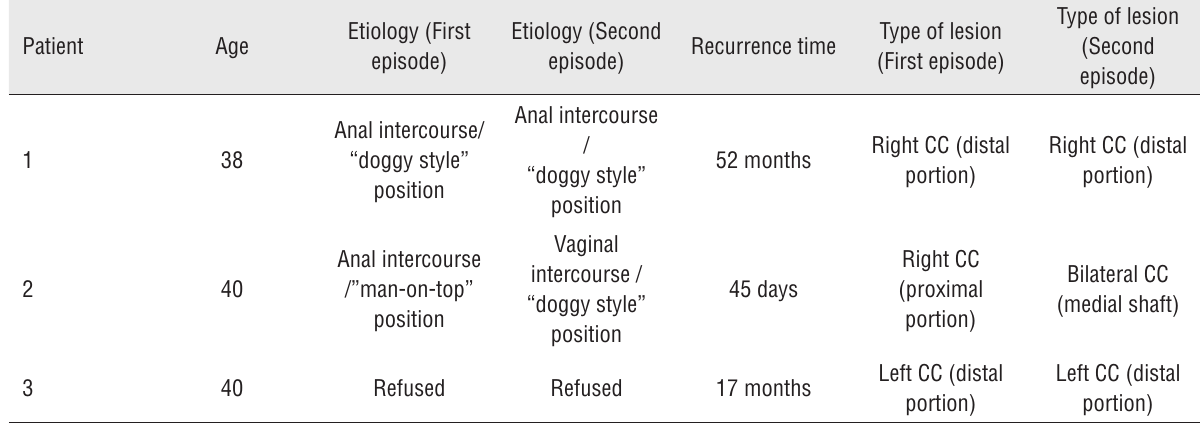
Table 1 - The table shows the demographic data and operative findings of the 3 cases of penile refracture in our sample.